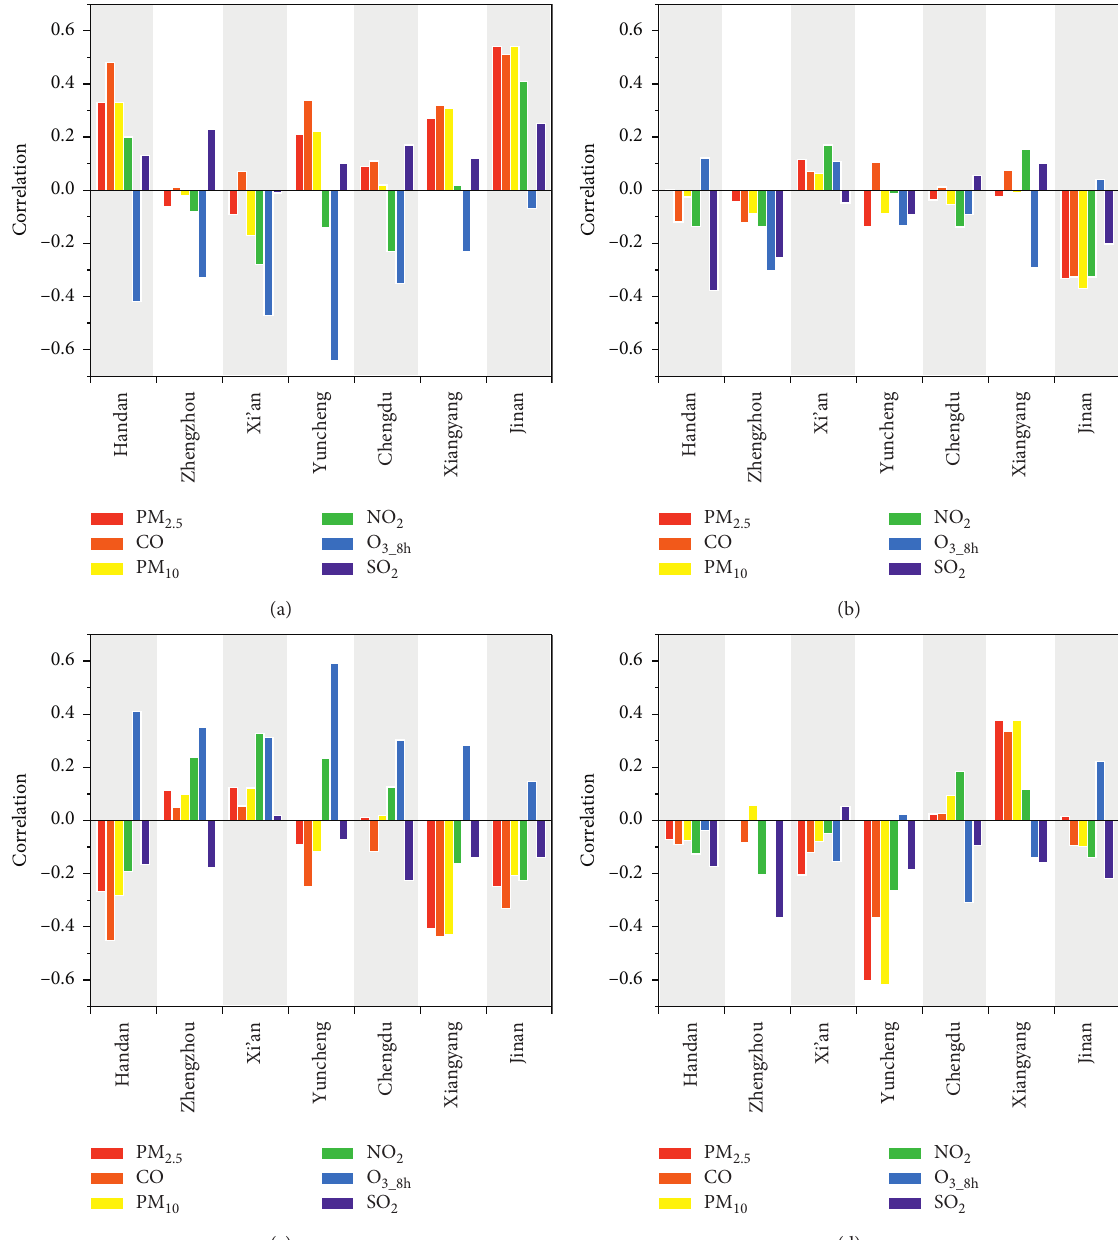
2.5 , PM 10 , CO, NO 2 , O 3 , and SO 2 in seven Chinese cities.